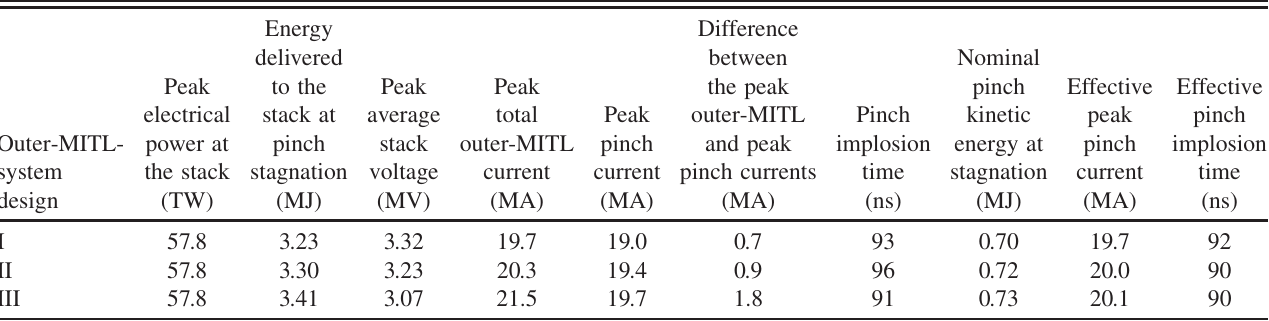
TABLE VI. Results of TL simulations for MITL designs I, II, and III. Nominal geometric impedances of the four outer MITLs for each design are listed in Table IV. These simulations assume a z -pinch load with a 1-cm length, 1-cm initial radius, and 5.88-mg total mass. The effective peak pinch current and effective pinch-implosion time are defined in Appendix C.